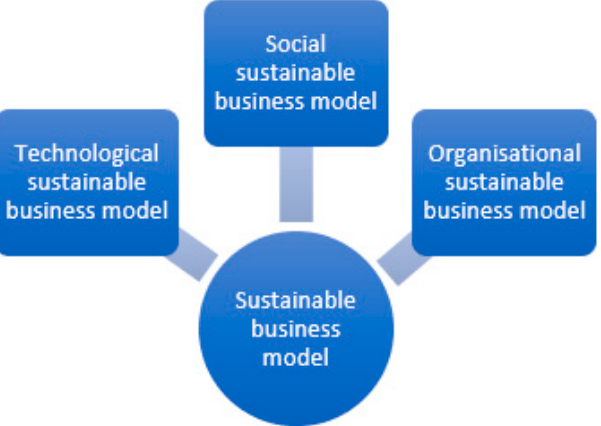
Figure 4. Sustainable business model types. Prepared on the basis of [7] (p. 48). The figure was created using Microsoft ® Word for Microsoft 365